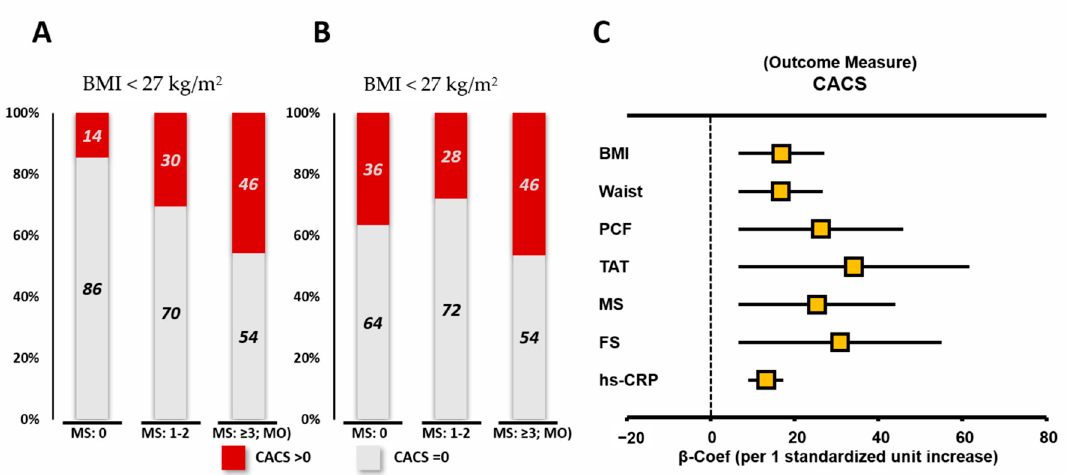
Figure 2. Prevalence of coronary artery calcification (CACS > 0, red) according to metabolic scoring and metabolic unhealthy (MU) according to the body mass index (BMI) strata ( A , B ). Associations of atherosclerotic burden (CACS) with per one standardized unit increase of anthropometrics, visceral adiposity, and cardiovascular risk scoring ( C ). FS: Framingham score, PCF: pericardial fat, TAT: thoracic peri-aortic fat, MS: metabolic